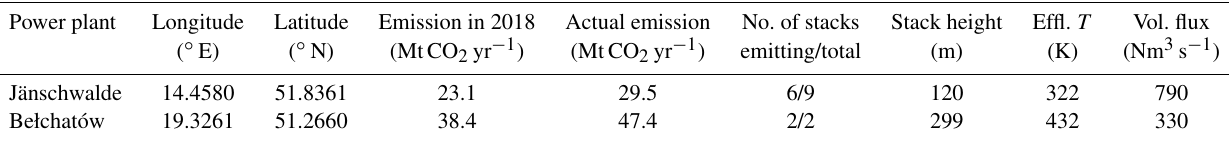
Table 2. Power plants and their 2018 annual mean CO 2 emissions and actual emissions during the observation periods. All model results are based on actual emissions. Flue gas temperature and effluent flux were estimated from published power plant statistics for Germany (Pregger and Friedrich, 2009), as these were not officially